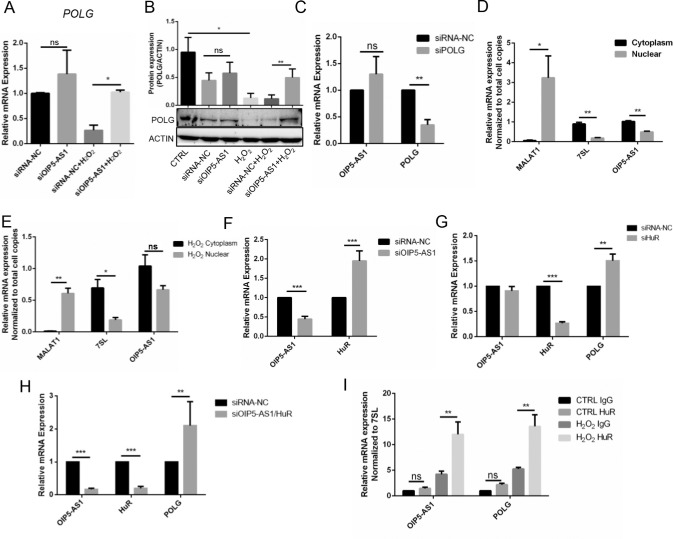
HuR bound OIP5-AS1 and POLG mRNA and mediated the decay of POLG mRNA. (A) POLG mRNA expression after OIP5-AS1 knockdown with or without H2O2 shown by RT-qPCR. (B) POLG protein expression after OIP5-AS1 knockdown with or without H2O2 shown by Western blots and quantification with ImageJ. (C) RT-qPCR detection of OIP5-AS1 expression after POLG knockdown. (D) RT-qPCR determination of OIP5-AS1 cell distribution in fractions of B3 cells. MALAT1 localized in the nucleus, and 7SL was expressed in the cytoplasm. (E) RT-qPCR determination of OIP5-AS1 cell distribution in cell fractions of B3 cells treated with H2O2. MALAT1 localized in the nucleus, and 7SL was expressed in the cytoplasm. (F) HuR mRNA expression after OIP5-AS1 knockdown shown by RT-qPCR. (G) OIP5-AS1 and POLG mRNA expression after HuR silencing shown by RT-qPCR. (H) POLG mRNA expression was upregulated after both OIP5-AS1 and HuR knockdown. (I) RIP detection of HuR binding of the mRNA of OIP5-AS1 and POLG with or without H2O2 stress. *P < 0.05, **P < 0.01, ***P < 0.001, ns: P > 0.05.